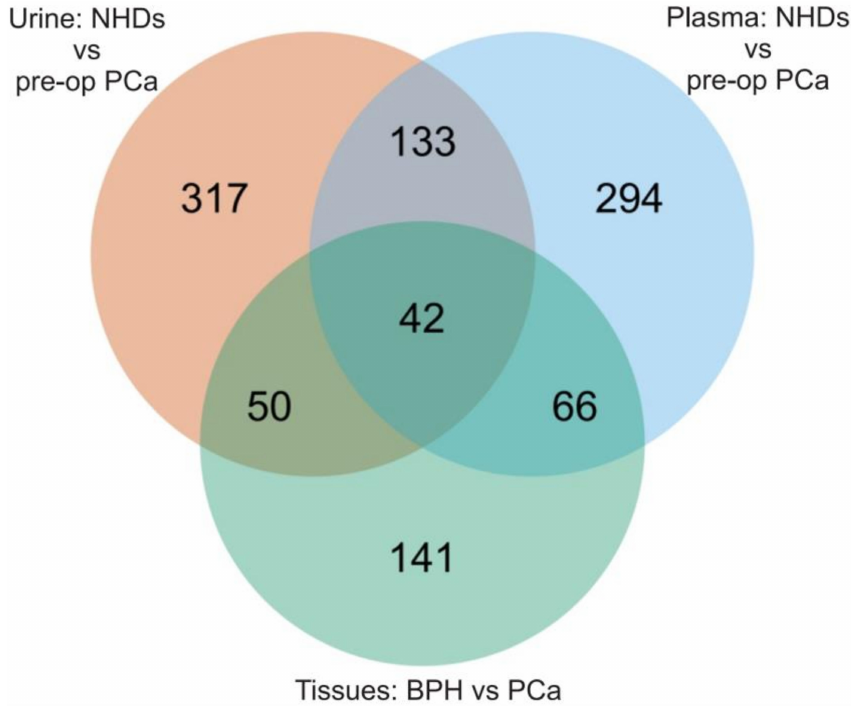
Figure 4. Overlapping DE miRs detected among plasma, urine, and FFPE tissue samples. The Venn diagram shows the significant DE miRs that overlap in all types of samples